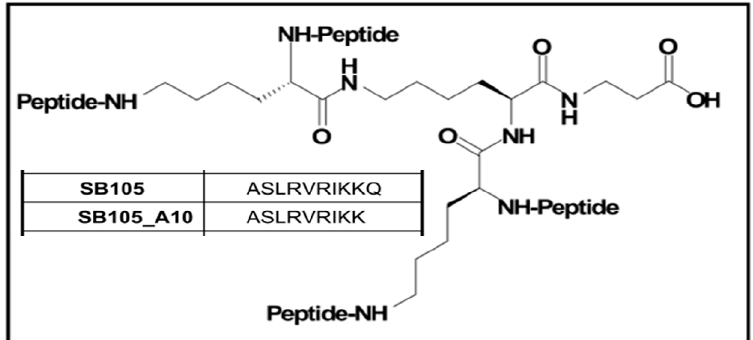
Figure 5. Structures of SB105 and SB105-A10 antiviral peptide-derivatized dendrimers. The generic structure of the peptide is shown. These molecules were synthesized by the addition of four 10-mer peptide chains to a tetrameric lysine central core. The amino acid sequence of each dendrimer peptide functional group is shown in the inset. See the main text for further details.